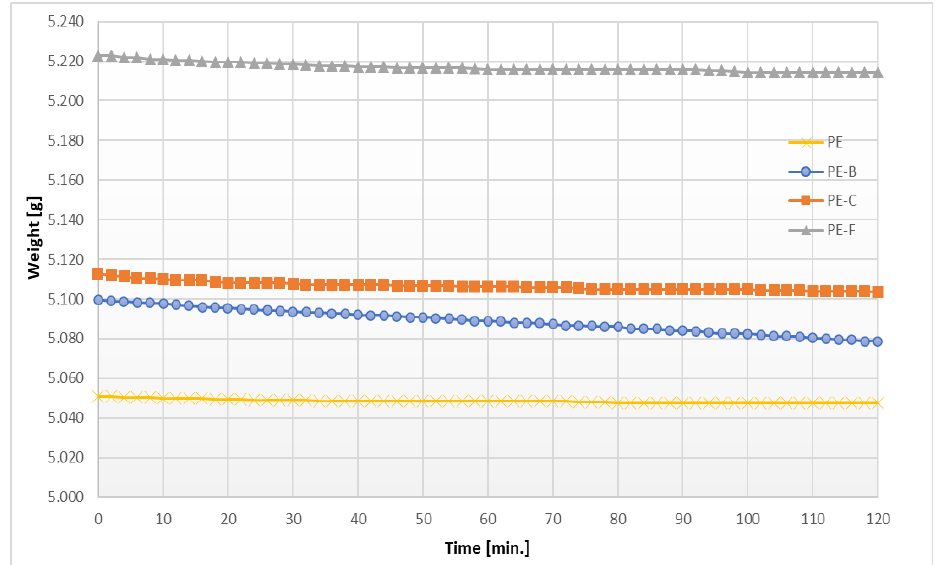
Figure 5. The course of mass measurement in the process of water vapor permeability determination on the example PE–pomace based membranes.